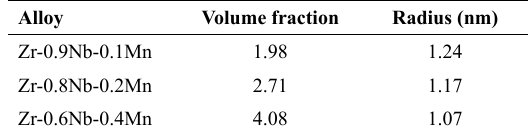
Table 1. Simulation of volume fraction and mean radius by TC-Prisma.